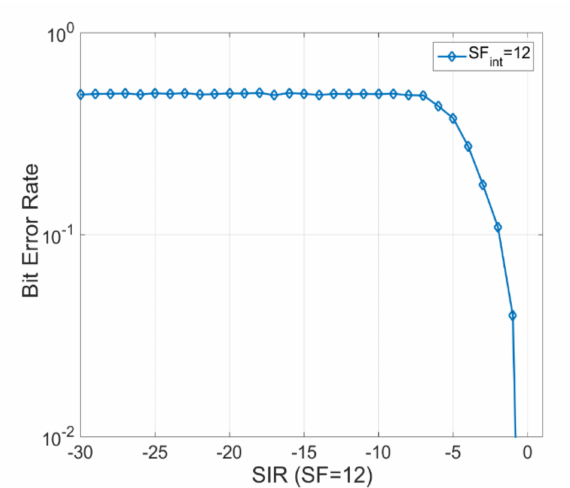
Figure 3. Bit Error Rate (BER) parameter for SF12, bandwidth (BW) = 125 kHz. The figure depicts the BER parameter when the SF12 spreading factor is used for a 125 kHz channel bandwidth. One can observe a decrease in